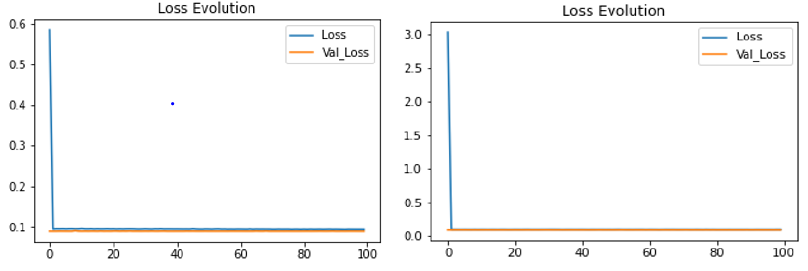
Figure 8. Loss metrics: ( left ) steering angle and ( right ) speed on the real